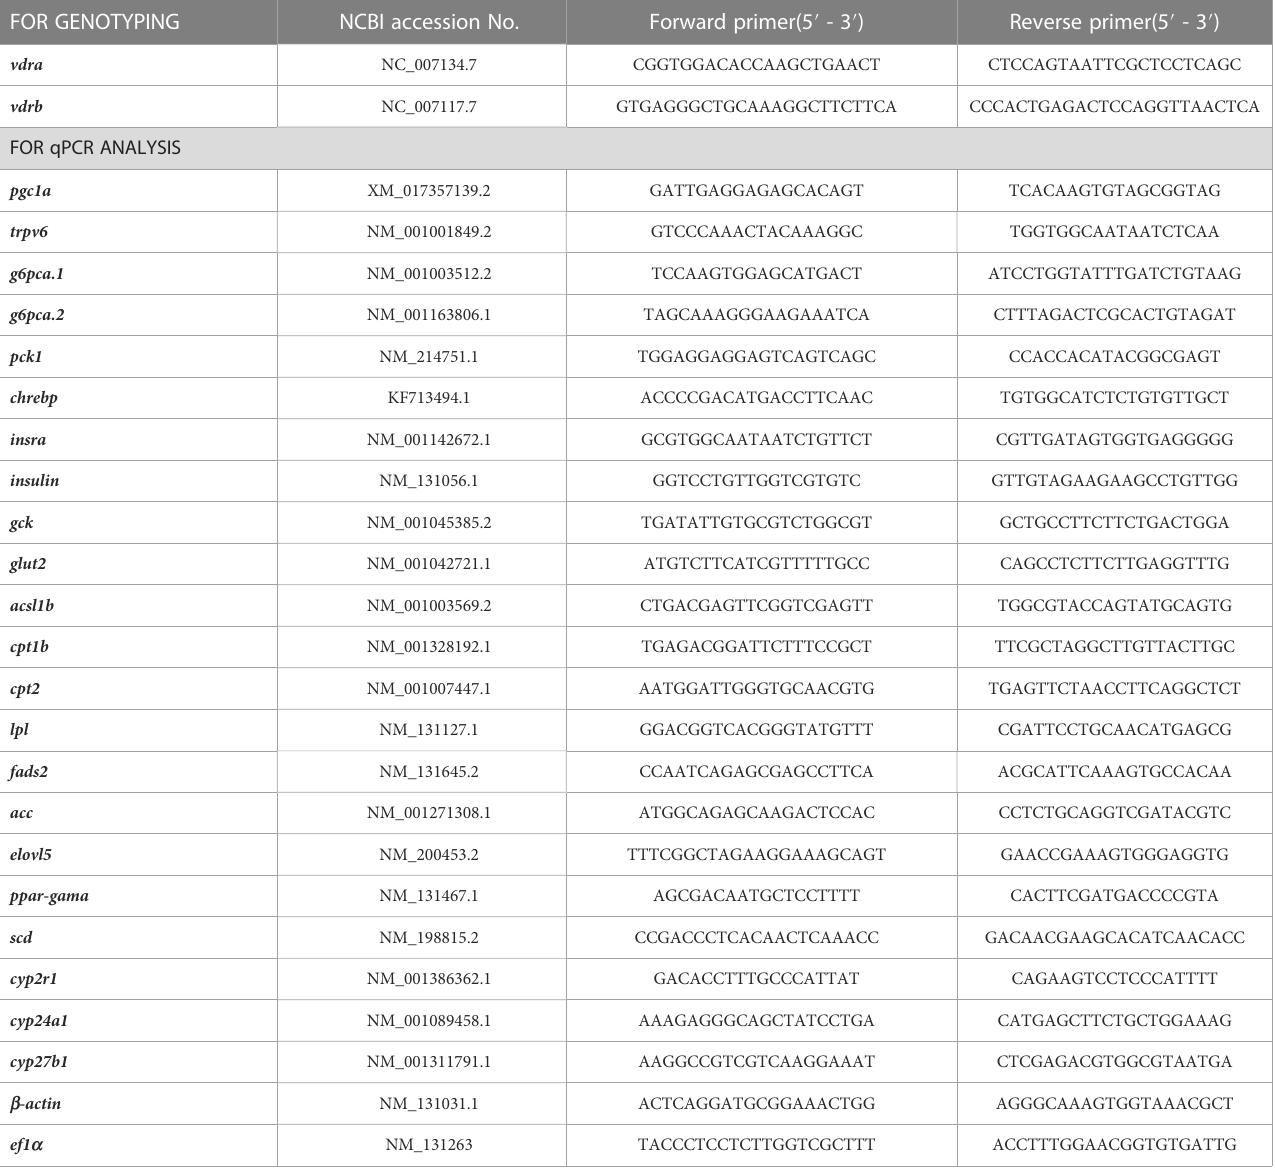
TABLE 1 The primers used in the